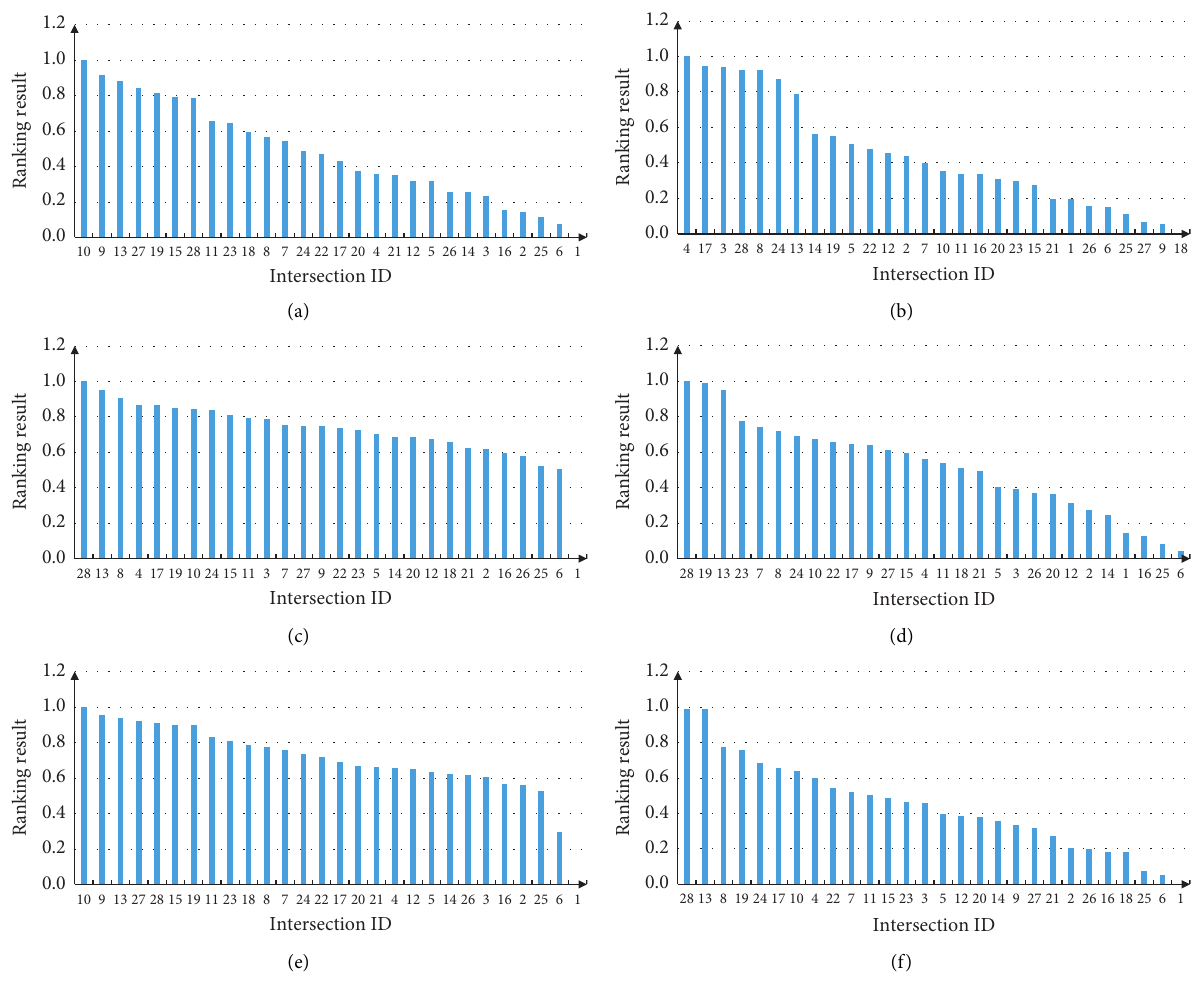
Figure 3: Comparison of the ranking results with analyzed intersections: (a) ranking results of node importance, (b) ranking results of traffic safety, (c) ranking results of strategy 1, (d) ranking results of strategy 2, (e) ranking results of strategy 3, and (f) ranking results of strategy